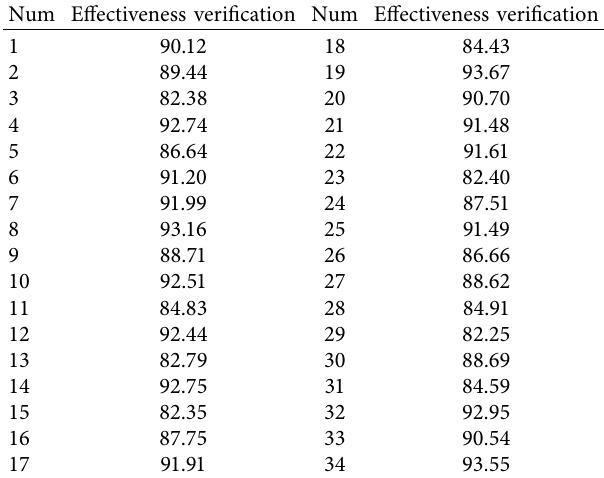
Table 1: Verification of the effect of smart city